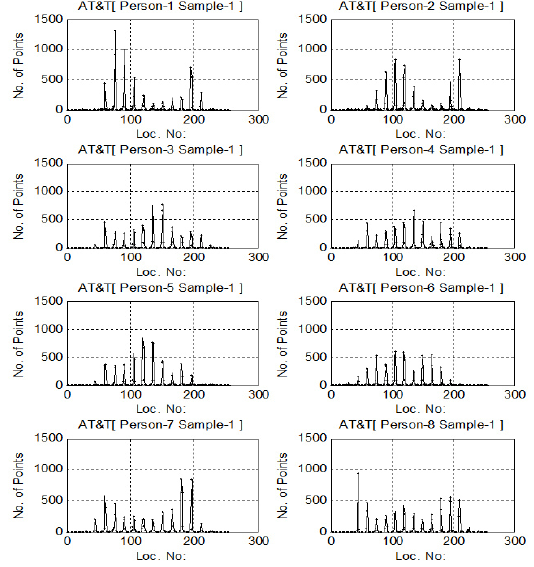
Fig. 10: State space point distribution graphs of first 8 persons’ face image in AT & T face database